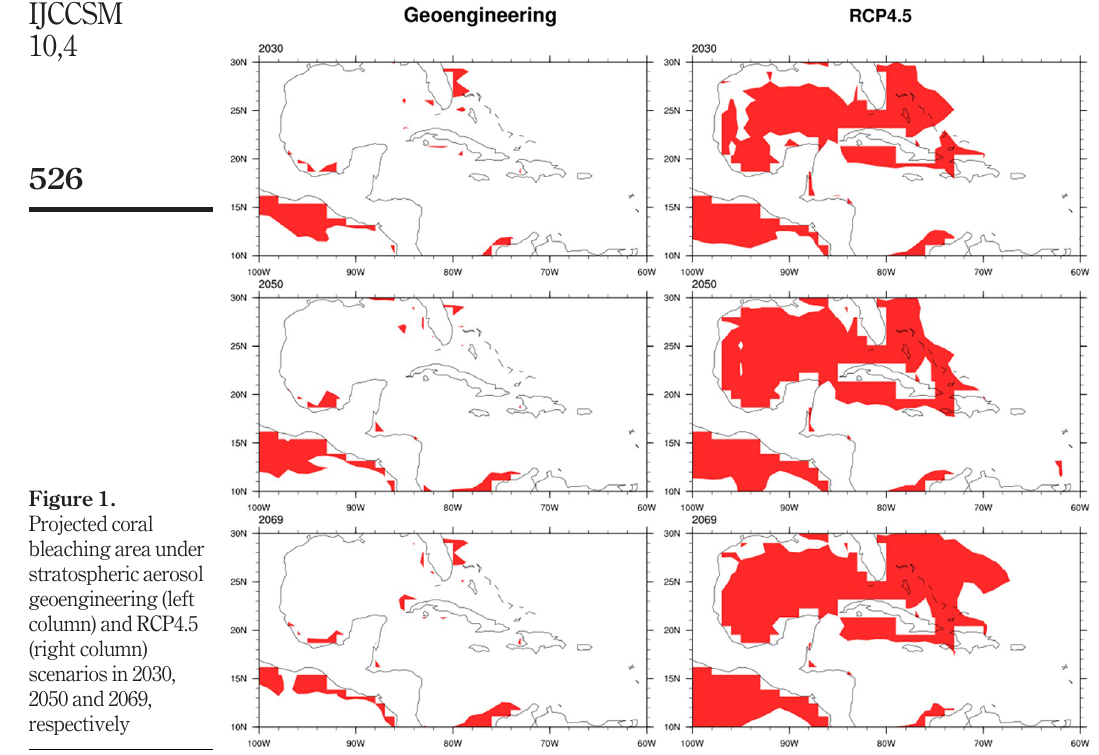
Figure 1. Projected coral bleaching area under stratospheric aerosol geoengineering (left column) and RCP4.5 (right column) scenarios in 2030, 2050 and 2069,